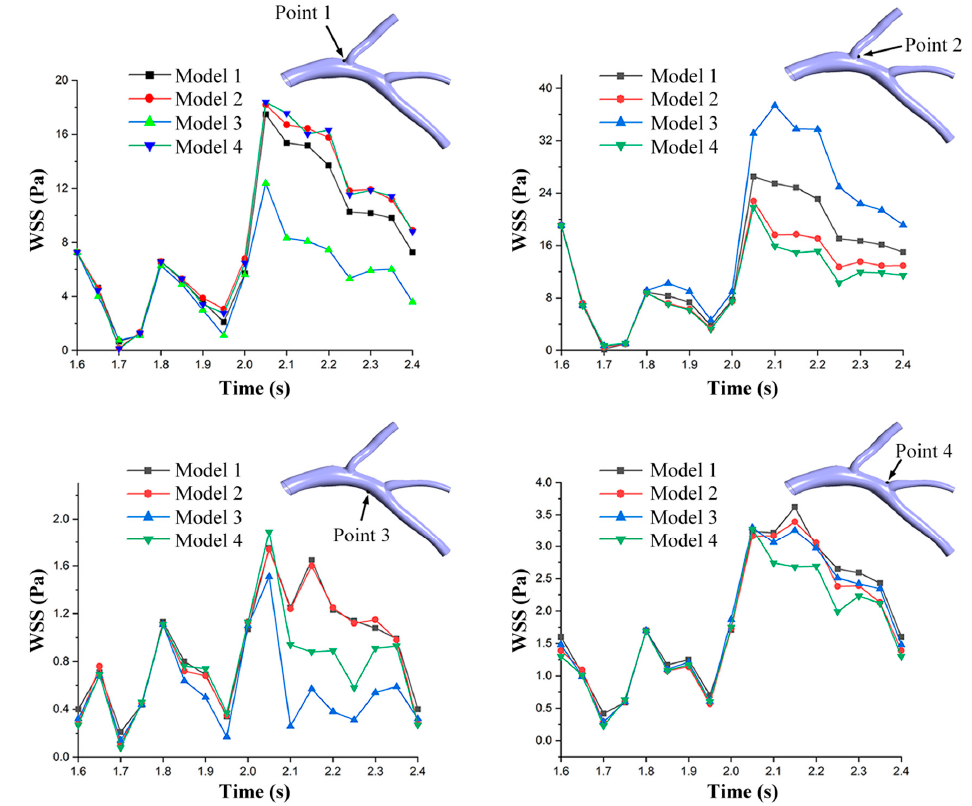
Figure 11. Line chart of the WSS changes at different positions in the cardiac cycle.